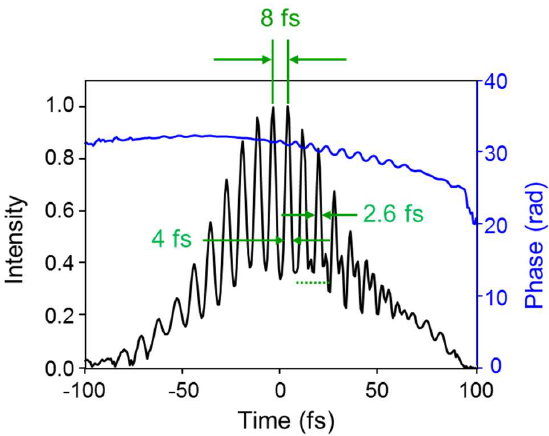
Figure 4. Temporal profile of the pulse train (black curve) and the phase of the pulse (blue curve).